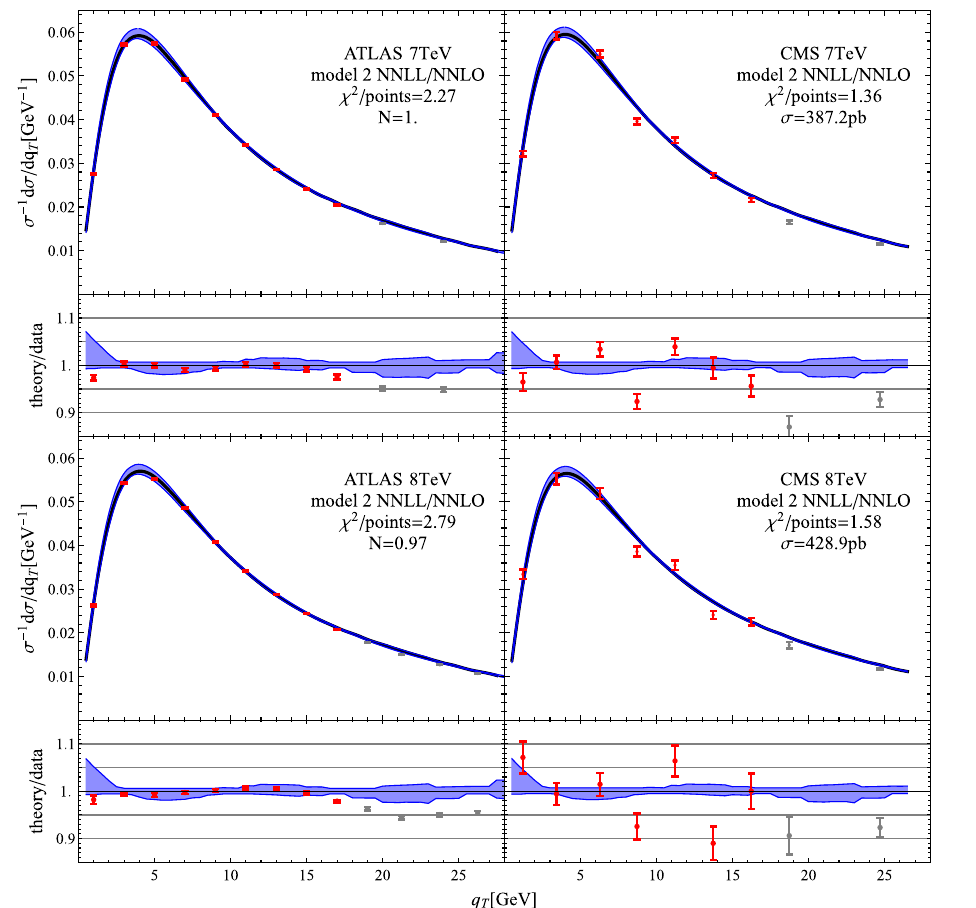
Fig. 11 The comparison of the data for Z-boson production collected at ATLAS and CMS experiments to the fit of model 2 at NNLL/NNLO. Red data points are those which included in the fit (i.e. with δ T = 0 . 2).